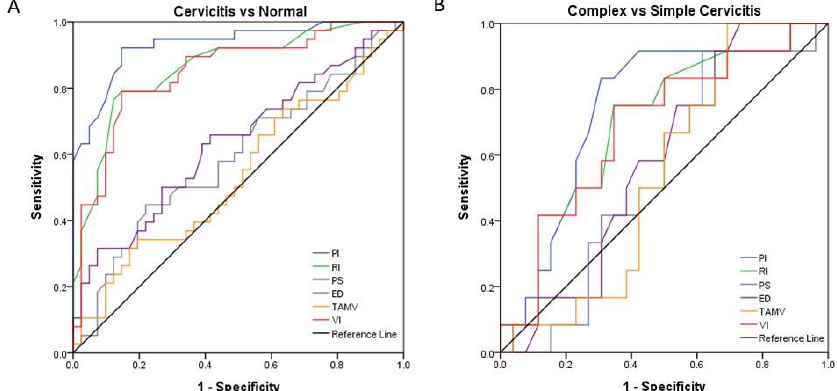
Figure 7. ( A ) ROC curve of six sonographic parameters between the case group ( n = 38) and control group ( n = 41). ( B ) ROC curve of six sonographic parameters between the group 2 ( n = 12) and group 1 ( n = 26). Table 3. Optimal cutoff values of six sonographic parameters for discriminating between the case group ( n = 38) and control group ( n = 41). It is also between complex cervicitis group (N = 12) with simple cervicitis group (N = 26).